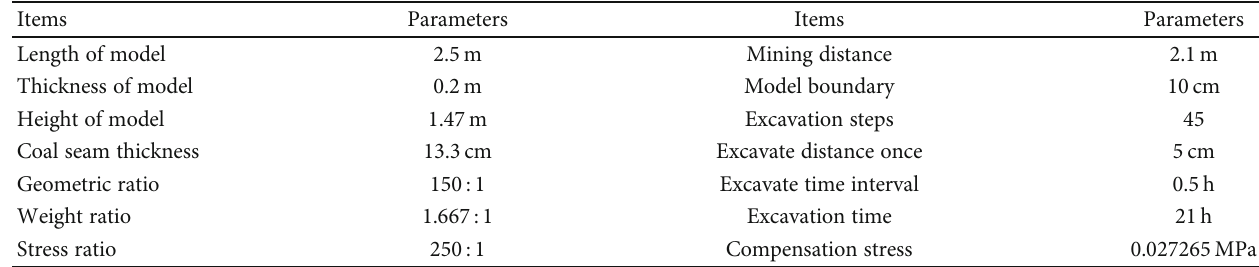
Table 2: Basic parameters of the physical similarity